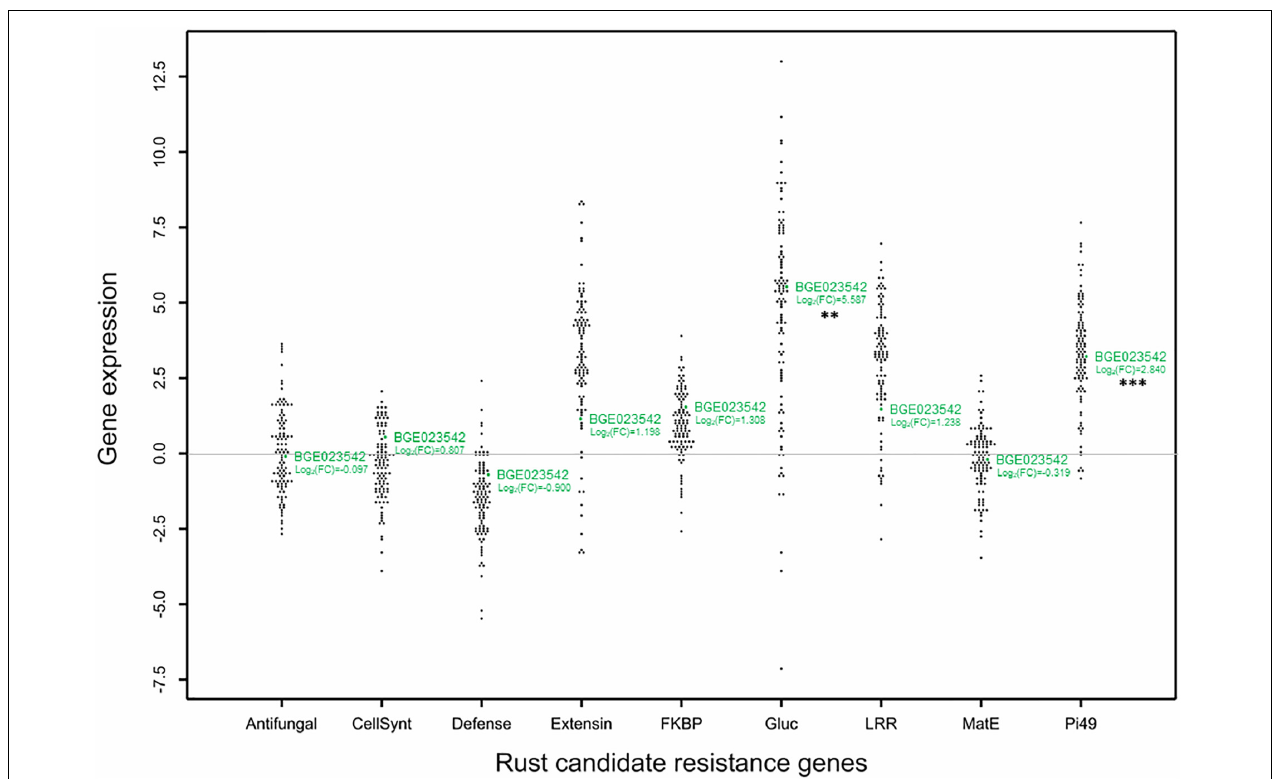
FIGURE 2 | Dot plots histogram showing the distribution of relative expression (Log 2 Fold change) of the selected genes related to rust partial resistance in the Lathyrus cicera recombinant inbred line (RIL) population (BGE023542 × BGE008277). The log 2 Fold Change values are represented in relation to the calibrator susceptible BGE008277 parental line, displayed by the horizontal line crossing Y -axis origin (log 2 Fold Change = 0). Each black and green dot represents an RIL individual and the BGE023542 (partial resistant) parental line, respectively. P -values obtained from t -test calculated between relative expression of parental lines for each gene are indicated by asterisks as follows: ∗∗ P < 0.01 ( Gluc ) and ∗∗∗ P < 0.001 ( Pi49